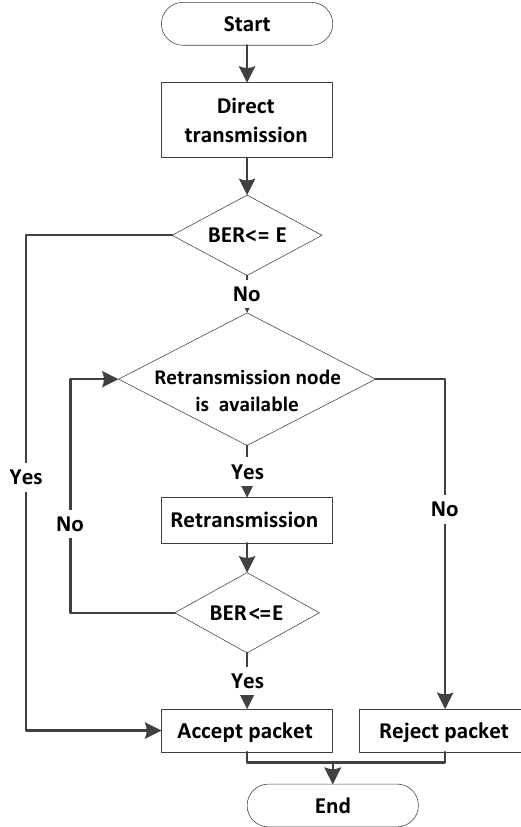
Figure 7. Data transmission flow chart for Enhanced-Adaptive Cooperation in Energy